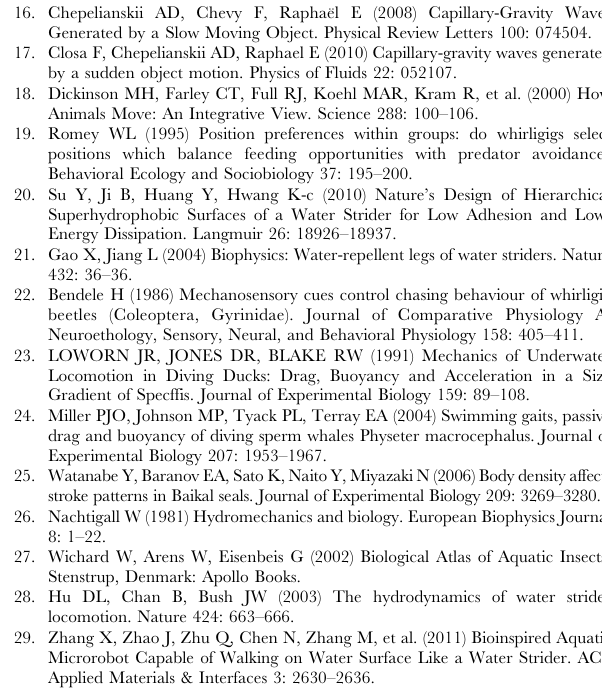
Figure S1 The swimming dynamics analysis of whirli- gig beetles. (A) Both the rowing of middle legs and striking of hind legs will generate the force component in the longitudinal and lateral directions. The lateral force component will form the centripetal acceleration to change the direction of the forward speed. The net torque produced by the striking of one hind leg will result in a rotation of the whirligig beetle’s rigid body. (B) The body coordinate system of the whirligig beetle. The increment of displacement in the y direction is assumed to always be positive. The increment of displacement in the x direction is negative in the left hand direction. The increment of the turning angle of the body is positive in the counterclockwise direction. Figure S2 The dynamics modeling for the diving process of the whirligig beetle. (A) the pre-diving process, (B) the diving process. The diving is powered by a torque T x combining the forces generated by striking the middle and hind legs and the fluid resistance. The beetle will turn its body perpendicular to the free water surface, towards decreasing the water resistance and surface tension. Table S1 Parametric analysis of swimming